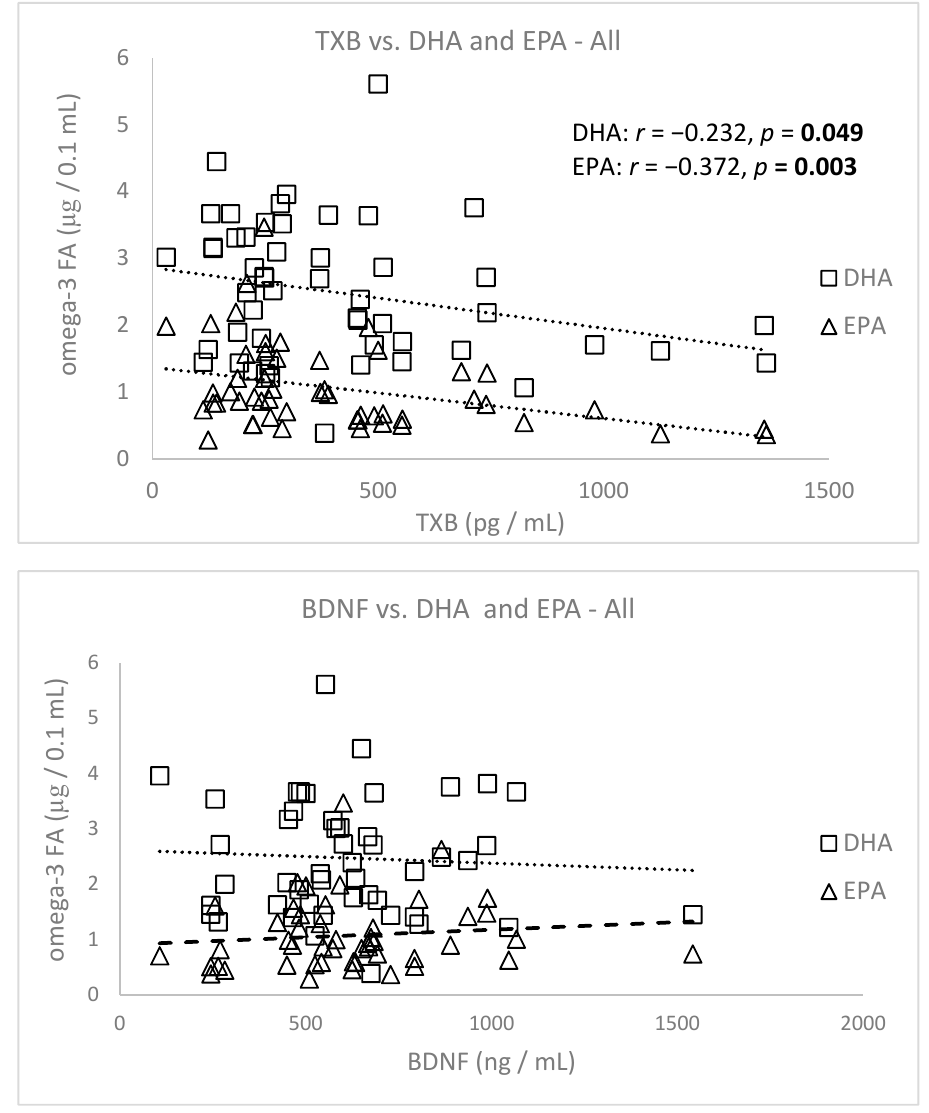
Figure 5. Correlations of basal TXB and BDNF with docosahexaenoic acid (DHA) and eicosapentaenoic acid (EPA) in depressed patients. TXB–thromboxane, BDNF–brain derived neurotrophic factor.